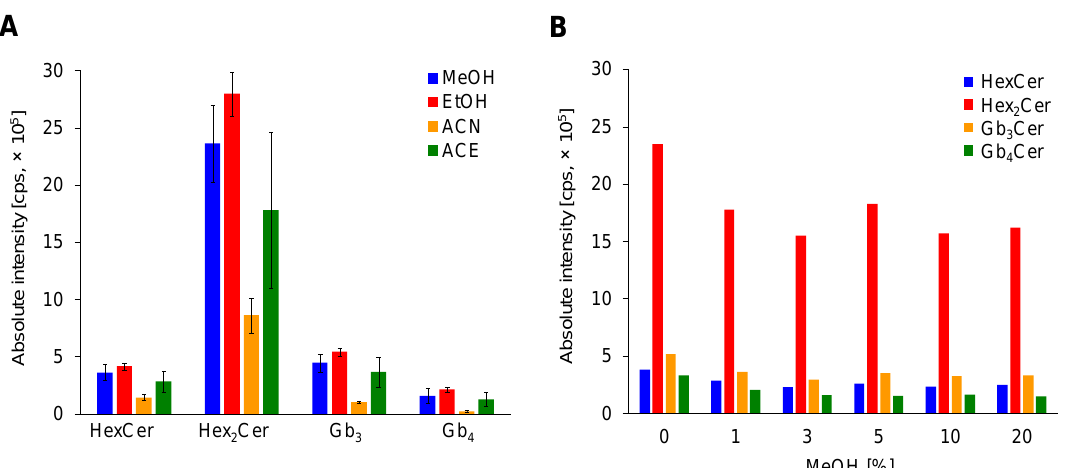
Figure 3. Optimization of sample preparation. ( A ) Comparison of solvents methanol (MeOH), ethanol (EtOH), acetonitrile (ACN) and acetone (ACE) for plasma deproteinization. Bar graphs display means of absolute peak intensities of the most abundant species within particular GSL subclass, and error bars illustrate standard deviations within nine analyses. ( B ) Effect of MeOH % abundance in loading step.